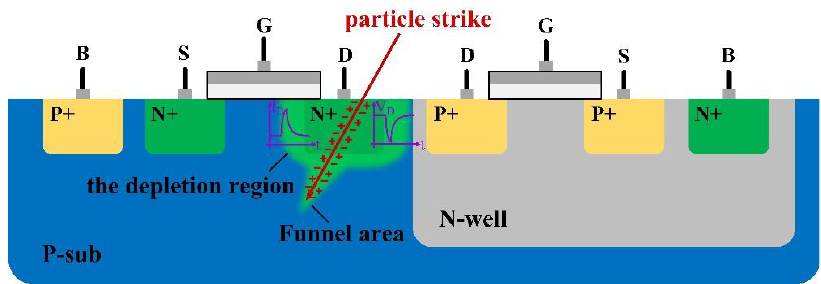
Figure 1. The Influence Mechanism of SET on CMOS Devices.